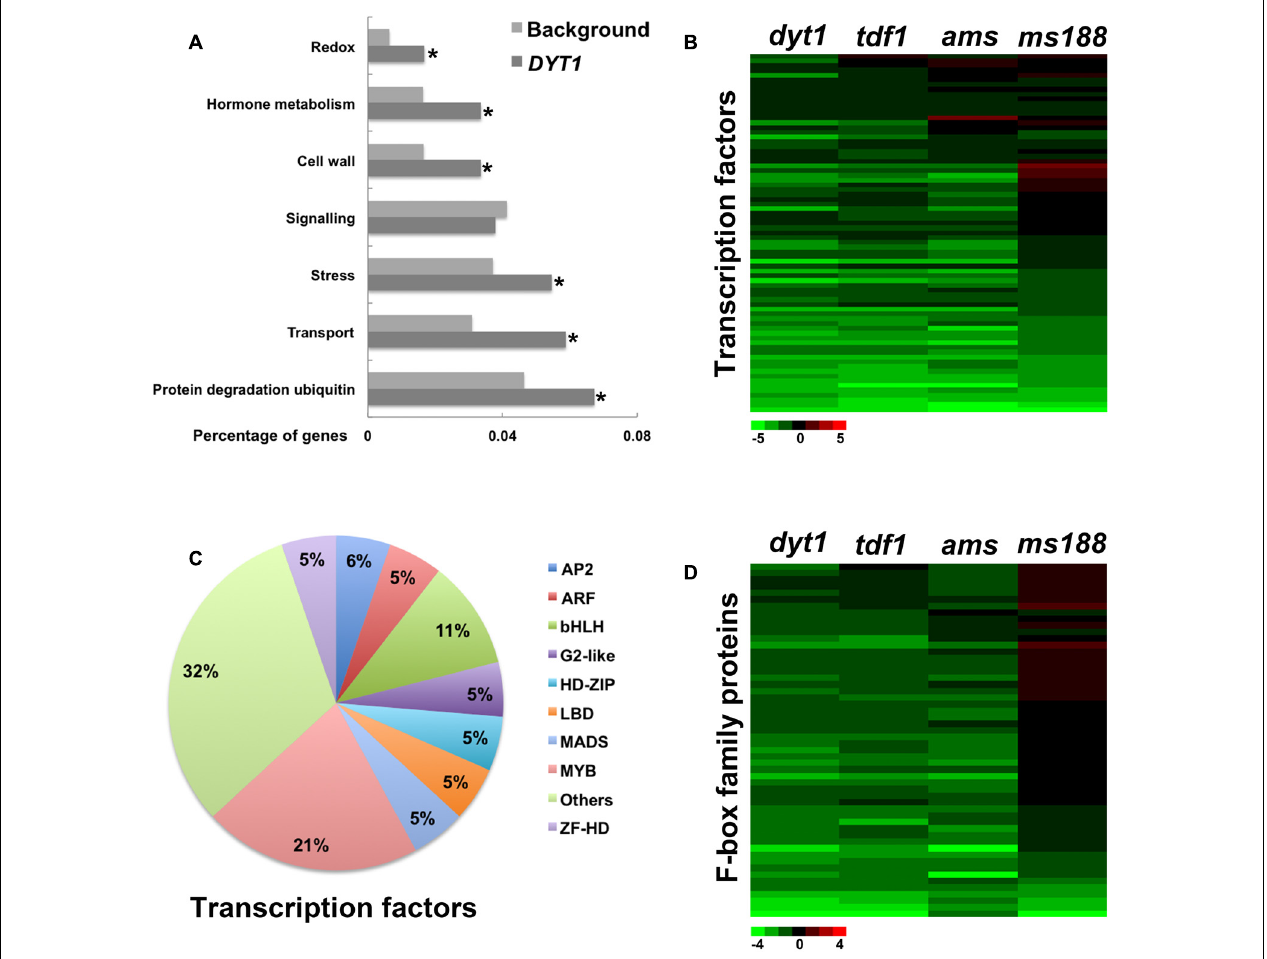
FIGURE 3 | Functional analysis of DYT1 -specific genes. (A) GO enrichment analysis of DYT1 -specific genes. (B) Heat map of mRNA expression profiles of transcription factors of DYT1 in dyt1 , tdf1 , ams , and ms188 mutants. Green and red colors represent lower and higher log 2 fold change of expression in mutants compared with the wild type. (C) Subsets in DYT1 -specific transcription factors. (D) Heat map of mRNA expression profiles of F-box family proteins of DYT1 in dyt1 , tdf1 , ams , and ms188 mutants. Green and red colors represent lower and higher log2 fold change of expression in mutants compared with the wild type. Asterisk indicates P values < 0.05 compared with